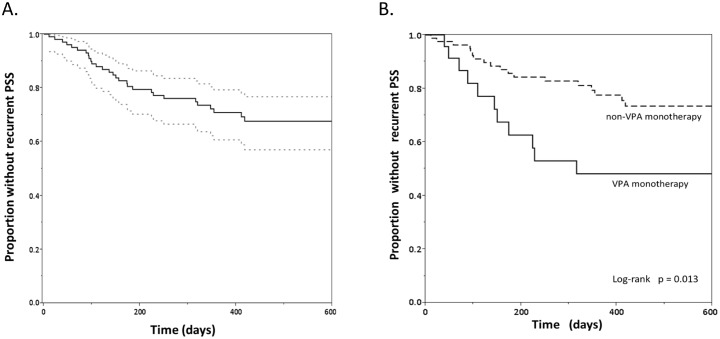
Kaplan—Meier curves for proportion without recurrent PSS.
A. After a median follow-up of 362 days, we identified recurrent PSS in 31 patients (29.8%). Dotted lines indicate the confidence interval. B. For patients who received (solid line) or did not receive (dotted line) valproic acid (VPA) monotherapy at the time of recurrence or end of follow-up. VPA monotherapy may be insufficient to prevent recurrent PSS (log-rank test, p = 0.013).